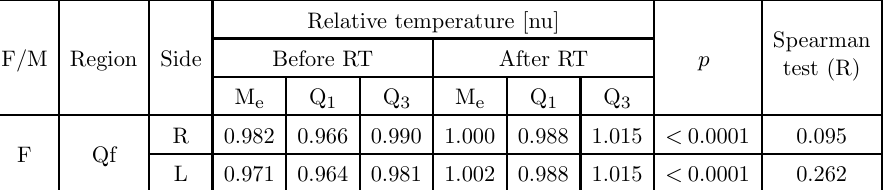
Relative temperature [nu]